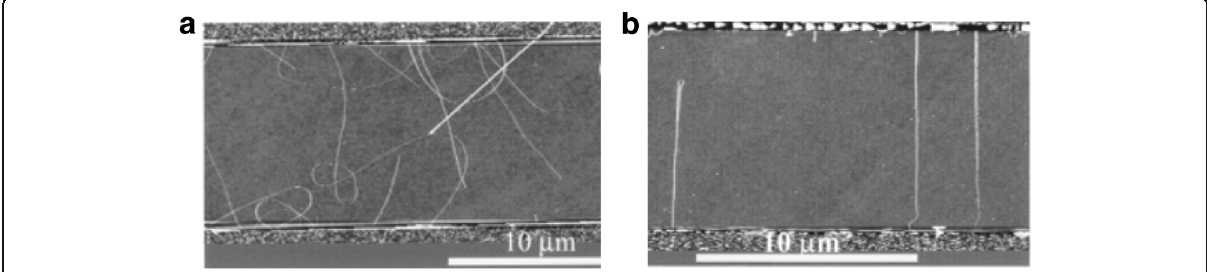
Fig. 28 AFM images of CNTs grown using CVD technique between two Mo electrodes which are shown on top and bottom of the images. a Randomly grown CNTs in the absence of an electric field. Adapted from [199]. b Aligned grown in the presence of an electric field (a bias voltage of 10 V bias applied between the electrodes having a gap of 10 μ m). Adapted from [199]